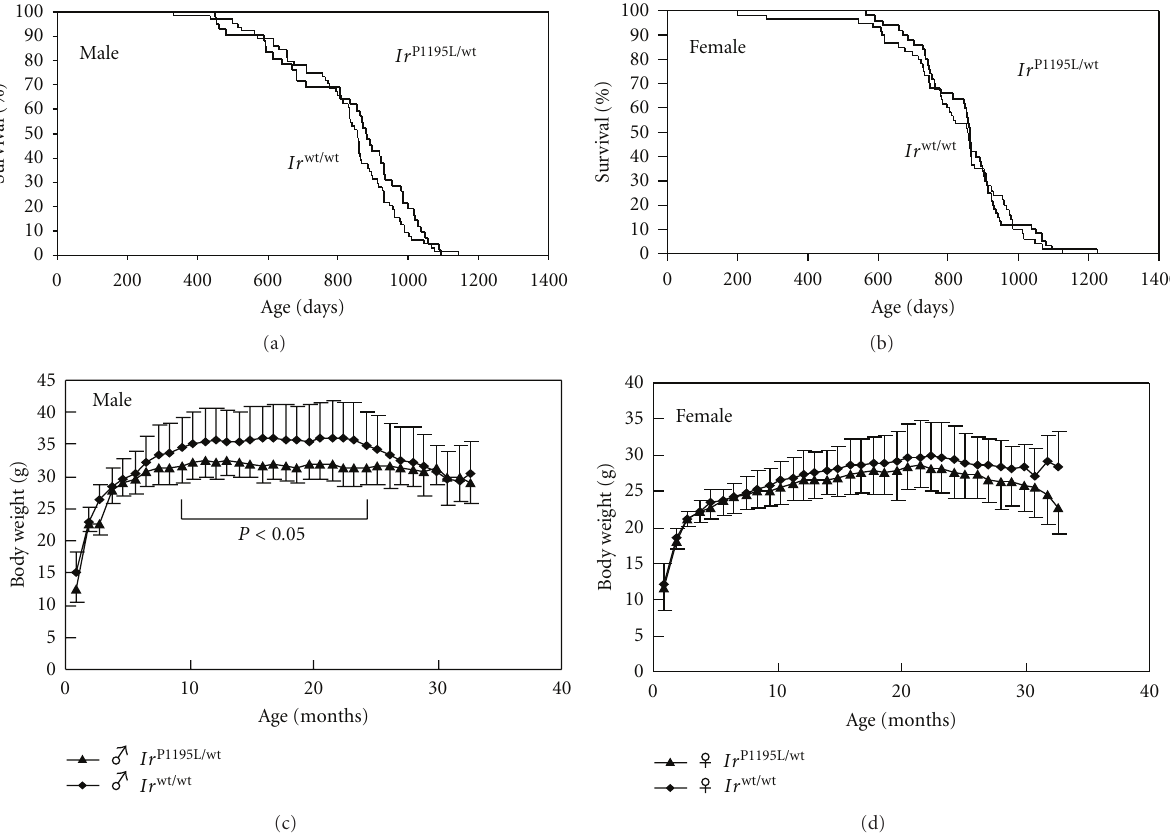
Figure 1: The survival curves and body weights of Ir P1195L / wt mice. (a) The Kaplan-Meier survival curves of Ir P1195L / wt male ( n = 42) and Ir wt / wt male ( n = 64) mice (generalized Wilcoxon test, P = 0 . 33). Bold and thin lines indicate Ir P1195L / wt and Ir wt / wt mice, respectively. (b) The Kaplan-Meier survival curves of Ir P1195L / wt female ( n = 50) and Ir wt / wt female ( n = 60) mice (generalized Wilcoxon test, P = 0 . 42). (c, d) The body weights of male (c) and female (d) mice. The Ir P1195L / wt male mice ( n = 28) showed significantly decreased body weight compared to that of Ir wt / wt male mice ( n = 36) from 9 to 25 months of age, while the Ir P1195L / wt female mice ( n = 39) failed to show any significant di ff erence compared to the Ir wt / wt female mice ( n = 47). Closed triangles and closed diamonds indicate Ir P1195L / wt and Ir wt / wt mice,